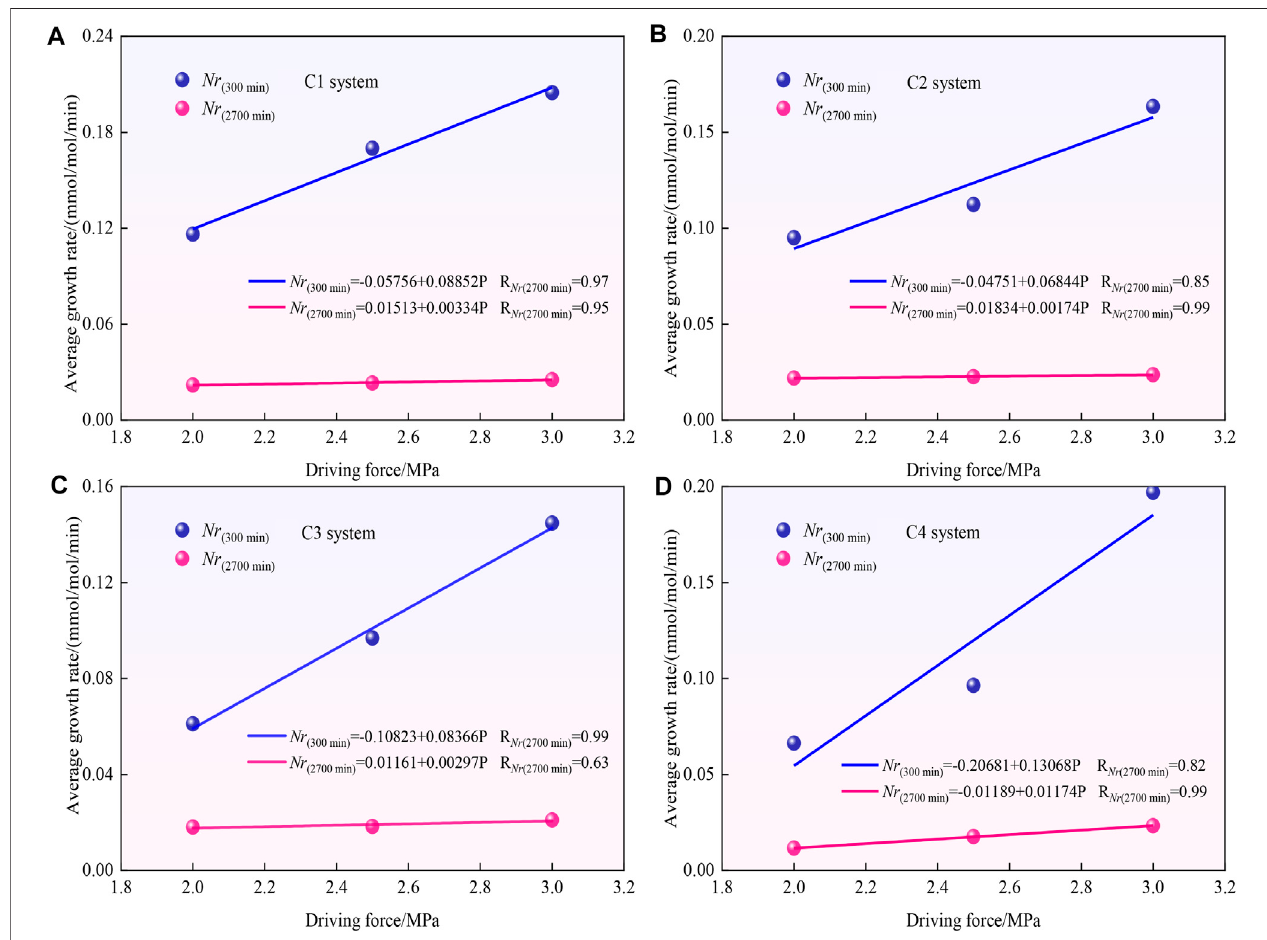
FIGURE 8 | Fitted plot of the average growth rate of CO 2 hydrates versus driving force in the C1-C4 systems.